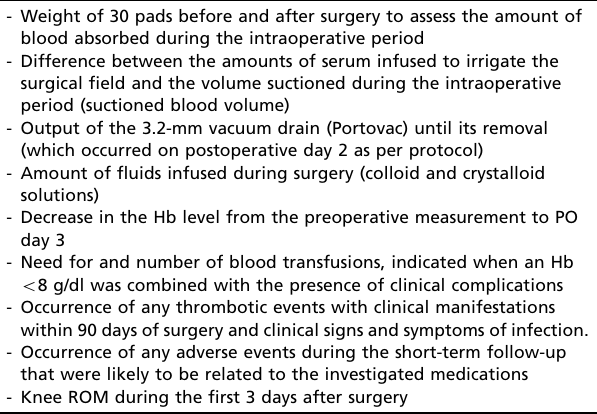
Table 2 - Parameters for evaluation.